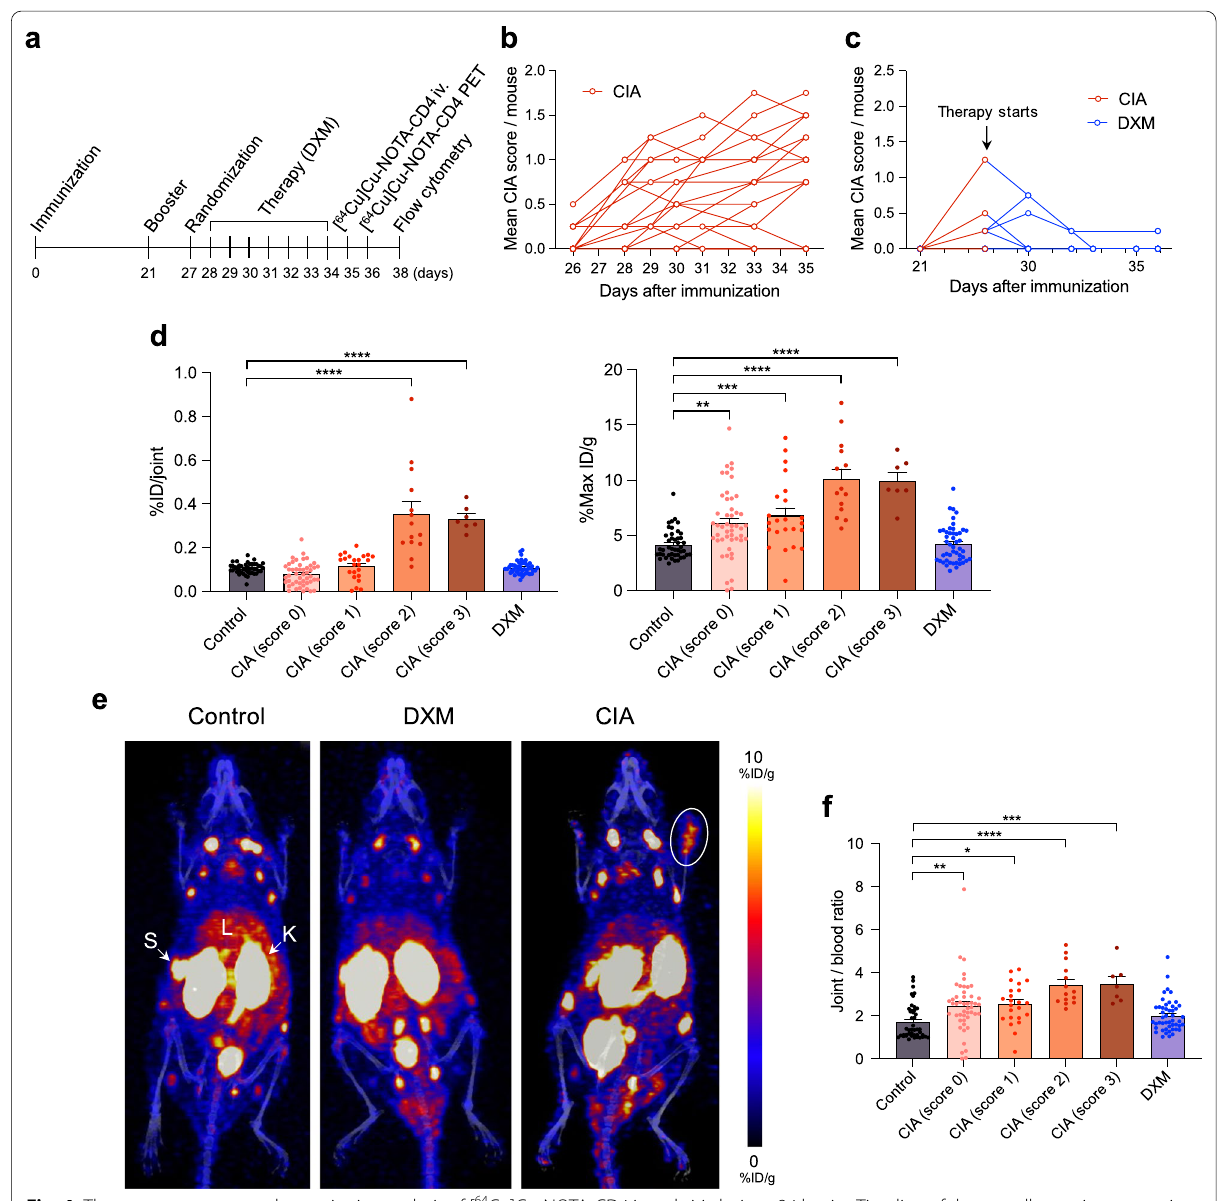
Fig. 4 Therapy assessment and quantitative analysis of [ 64 Cu]Cu-NOTA-CD4 in arthritic lesions 24 h p.i. a Timeline of the overall experiment starting at with immunization of collagen-induced arthritis (CIA) mice followed by booster injection three weeks later, treatment regimen, i.v. injection of [ 64 Cu]Cu-NOTA-CD4 and 24 h PET/CT imaging. Flow cytometric analysis of the carpal and tarsal joints was performed on the last day of the experiments. b Untreated CIA mice were scored according to degree of inflammation (swelling and erythema) in each paw on a scale from 0 to 4 (n 23) . Data are shown as mean CIA score per mouse starting on day 26 after immunization to injection of tracer (day 35). Each line represents = the development of arthritis in one mouse. c Mean CIA score per mouse of dexamethasone (DXM) (1 mg/kg, i.p.)-treated CIA mice ( n Quantitative analysis of [ 64 Cu]Cu-NOTA-CD4 uptake 24 h p.i. in the carpal and tarsal joints of control ( n CIA mice ( n 23). Uptake is calculated as %ID/joint and %Max ID/g. Each point represents a joint. e Representative maximum intensity projections = (coronal view) of control, DXM treated and untreated CIA mice. Images were acquired 24 h p.i. as maximum intensity projections (%ID/g). Liver (L), spleen (S), kidney (K) and white ring encircle a joint with high [ 64 Cu]Cu-NOTA-CD4 activity. f Joint/blood ratios of [ 64 Cu]Cu-NOTA-CD4 uptake in control, DXM treated and untreated CIA mice 24 h p.i. Data are presented as mean (*), p < 0.01 (**), p < 0.001 (***) and p < 0.0001